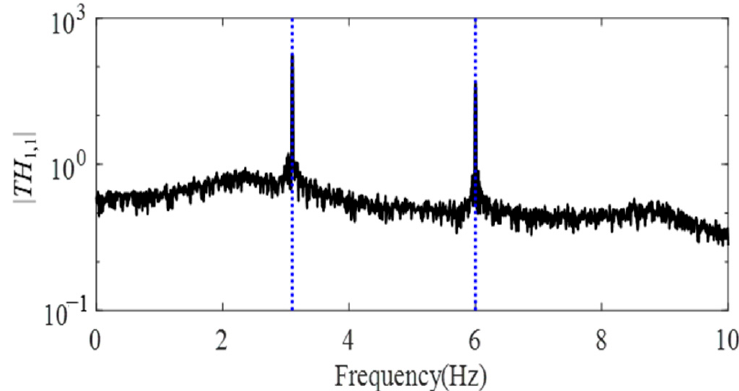
Figure 10. Natural frequency indication curve based on delayed transmissibility.